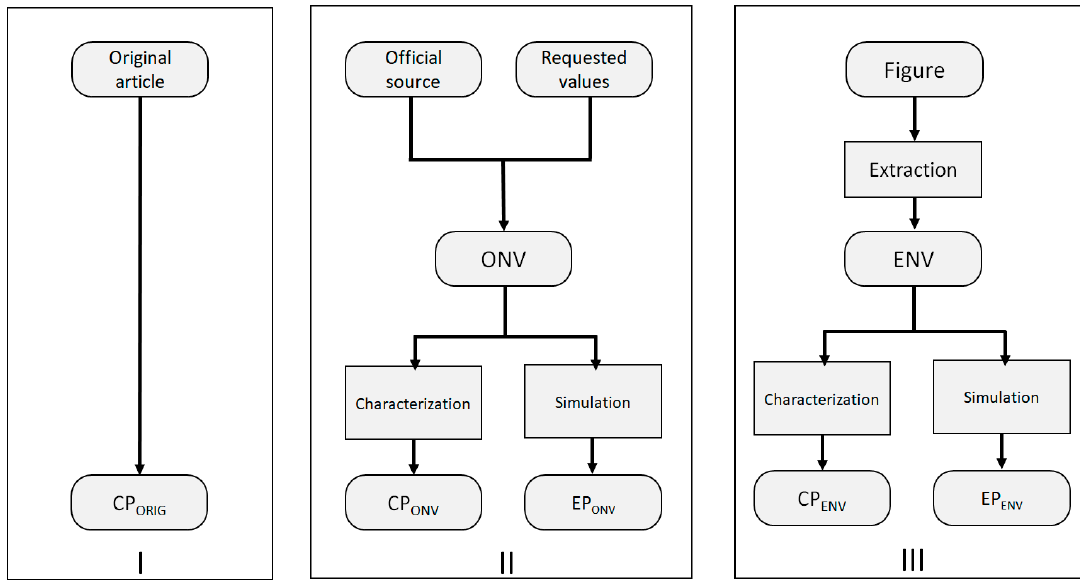
Figure 3. Flowchart explaining the methodology to obtain CPs and energy parameters (Eps).